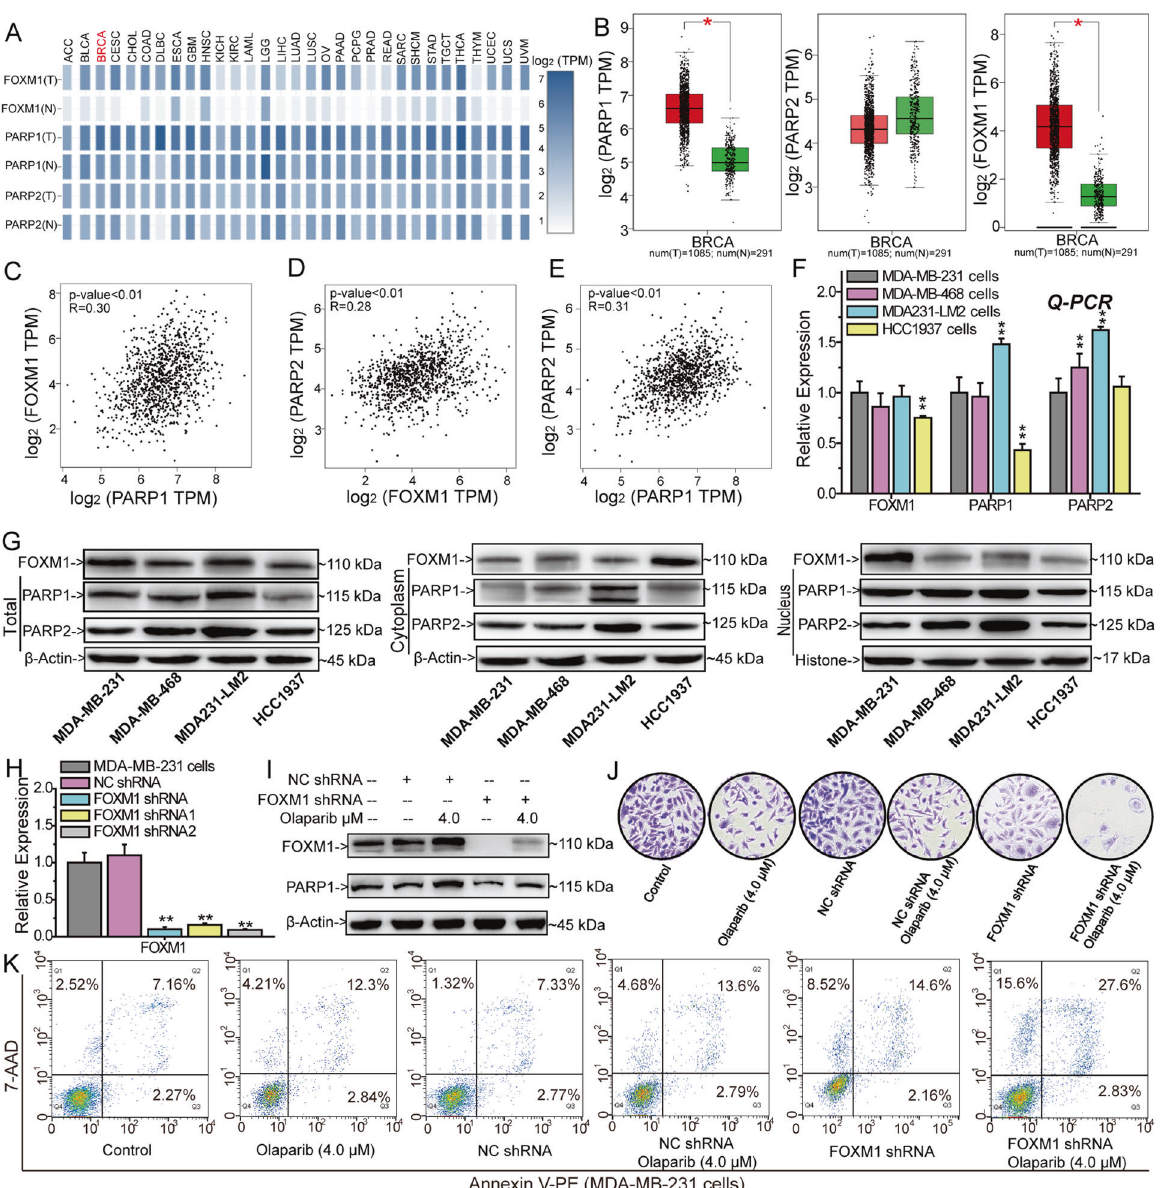
Fig. 1 FOXM1 knockdown inhibits PARP1 expression and sensitizes TNBC cells to Olaparib. A Differential expression of FOXM1, PARP1, and PARP2 between cancer tissues and adjacent tissues in TCGA project. B Box plots for the expression of PARP1, PAPR2, and FOXM1 between breast-invasive carcinoma tissues and adjacent tissues in TCGA project. Expression correlation analysis of PARP1 vs FOXM1 ( C ), PARP2 vs FOXM1 ( D ) and PARP1 vs PARP2 ( E ) based on the TCGA project samples. Relative expression of FOXM1, PARP1, and PARP2 in TNBC cell lines analyzed by Q-PCR ( F ) and Western blots ( G ). H Silencing FOXM1 expression by FOXM1 shRNA. I FOXM1 shRNA inhibits PARP1 and FOXM1 expression. FOXM1 shRNA and Olaparib synergistically inhibited the formation of MDA-MB-231 cell colonies ( J ) and promoted the apoptosis of MDA-MB-231 cells ( K ). The results from three independent experiments were statistically analyzed using a t-test : * P < 0.05, ** P < 0.01 compared with MDA-MB-231 G 2 /M transition and arrested the cell cycle at the G 2 /M phase (Fig. DCLK1, CCNA1, and polo-like kinase 1 (PLK1) (Fig. 4D). Subse- quently, we constructed a PPI network using PARP1, PARP2, and 5A and Supplementary Fig. 7A). Similarly, silencing the expression the fi ve genes as the centers by STRING. As shown in Fig. 4E, 23 of FOXM1 blocked the G 2 /M transition and arrested the cell cycle genes were selected for further mechanistic investigation. at the G 2 /M phase (Fig. 5B). Q-PCR and Western blots were used to analyze the expression of genes involved in cell cycle control based on the results of bioinformatic analysis in vitro and in vivo FDI-6 inhibits Olaparib-induced promotion of cell cycle (Fig. 5C – G, Supplementary Fig. 7B, Supplementary Fig. 8A – C, progression Supplementary Fig. 9 and Supplementary Fig. 10). CDK6, cyclin D1 Olaparib promoted the G 1 /S transition and arrested the cell cycle (CCND1), cyclin-dependent kinase 2 (CDK2), cyclin E2 (CCNE2), at the S and G 2 /M phases in MDA-MB-231 cells and MDA-MB-468 CDC25A and E2F transcription factor 2 (E2F2) regulate the G 1 /S cells. FDI-6 inhibited the G 2 /M transition and arrested the cell cycle at the G 2 /M phase. Combining FDI-6 with Olaparib inhibited the transition, and cyclin-dependent kinase 1 (CDK1), CCNA1, CCNB1,